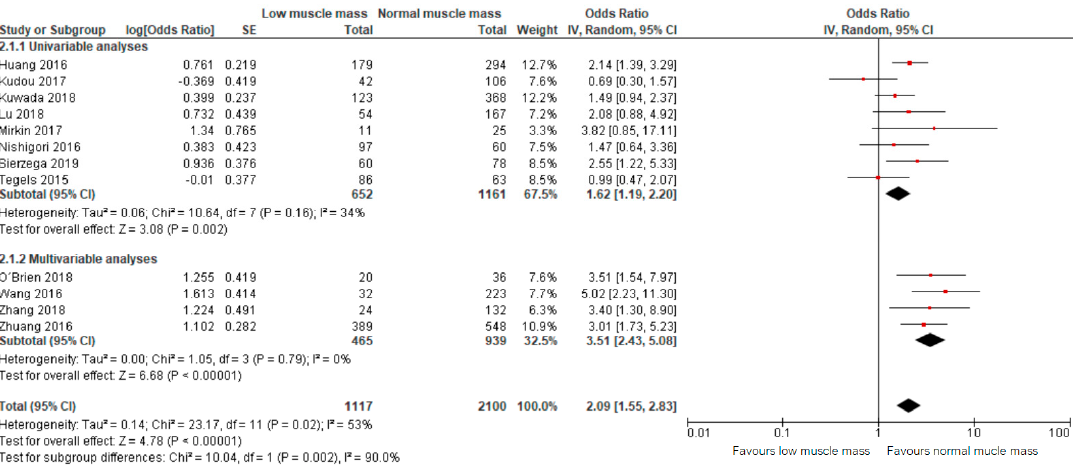
Figure 3. Forest plots of univariable and multivariable odds ratios for postoperative complications for gastric cancer patients with low muscle mass versus normal muscle mass.